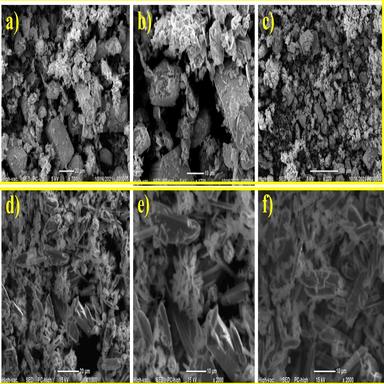
a)-c), and d)-f) are the SEM images of β-MNV and IL-β-MNV, respectively.